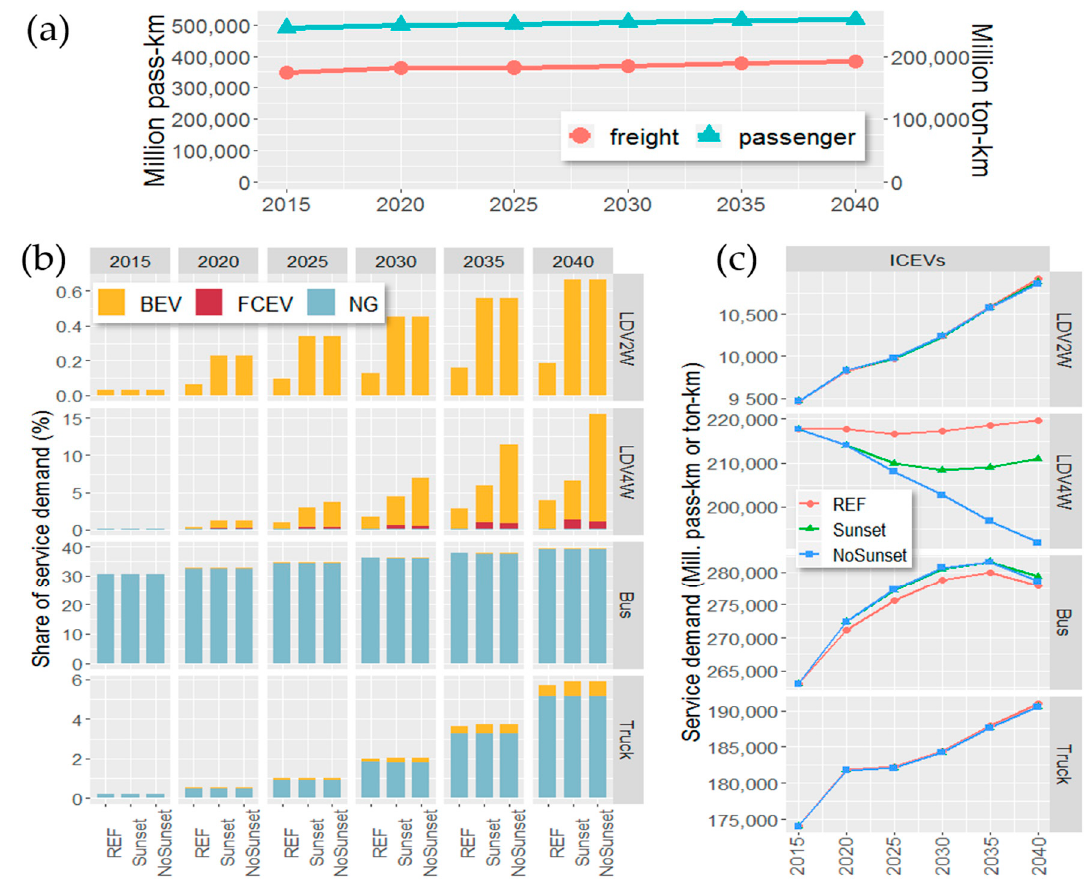
Figure 5. Service demand in the road transportation sector. Note: Total service demand: ( a ), Technology share ( b ), Service demand of ICEVs ( c ). The rest of the percentage of bars in ( b ) is the share of service demand for refined liquid vehicles.